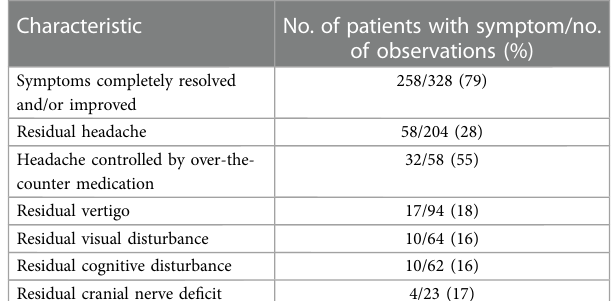
TABLE 3 Symptoms reported at postoperative follow-up among 454 patients with microsurgical treatment of unruptured intracranial aneurysms.